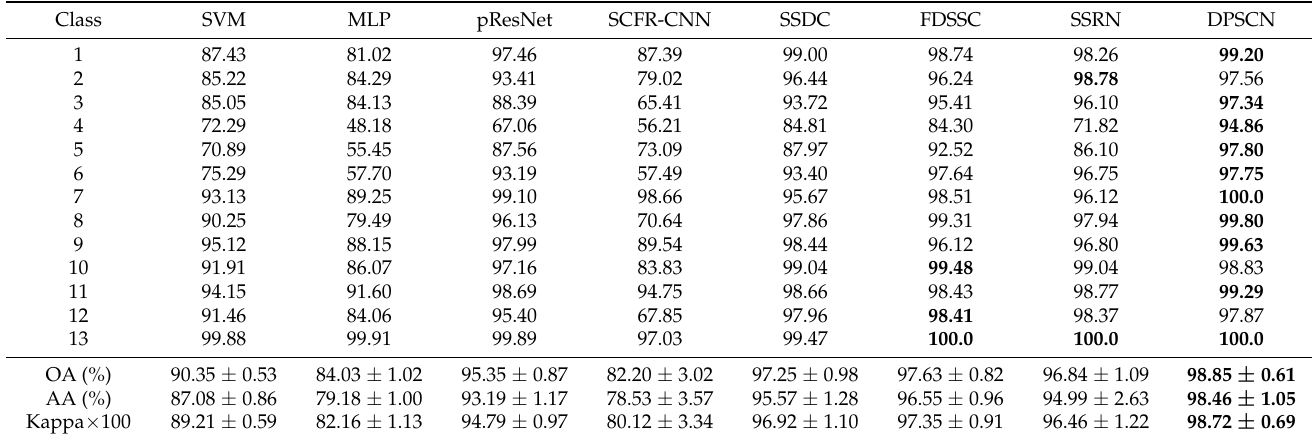
Table 8. Classification results of the different models for the KSC data set.